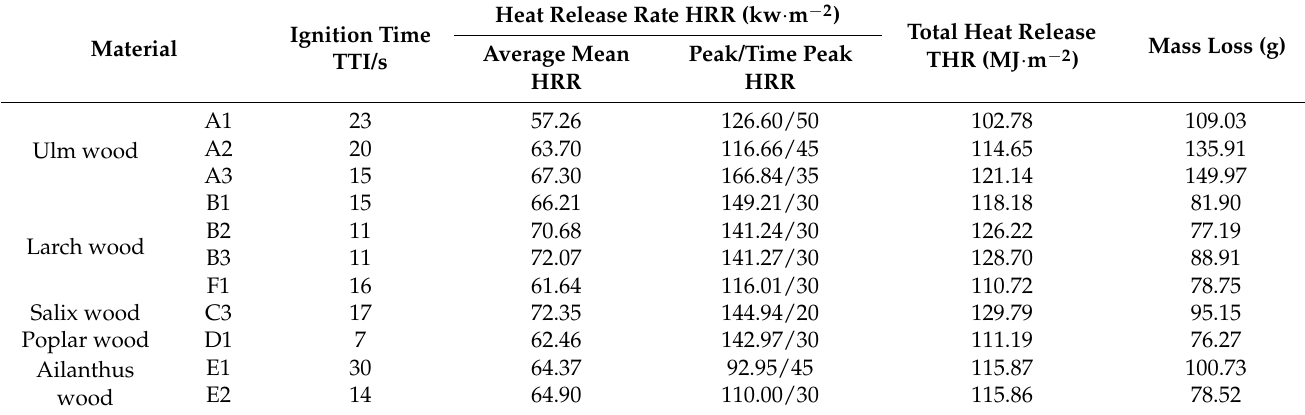
Table 3. Combustion performances of different